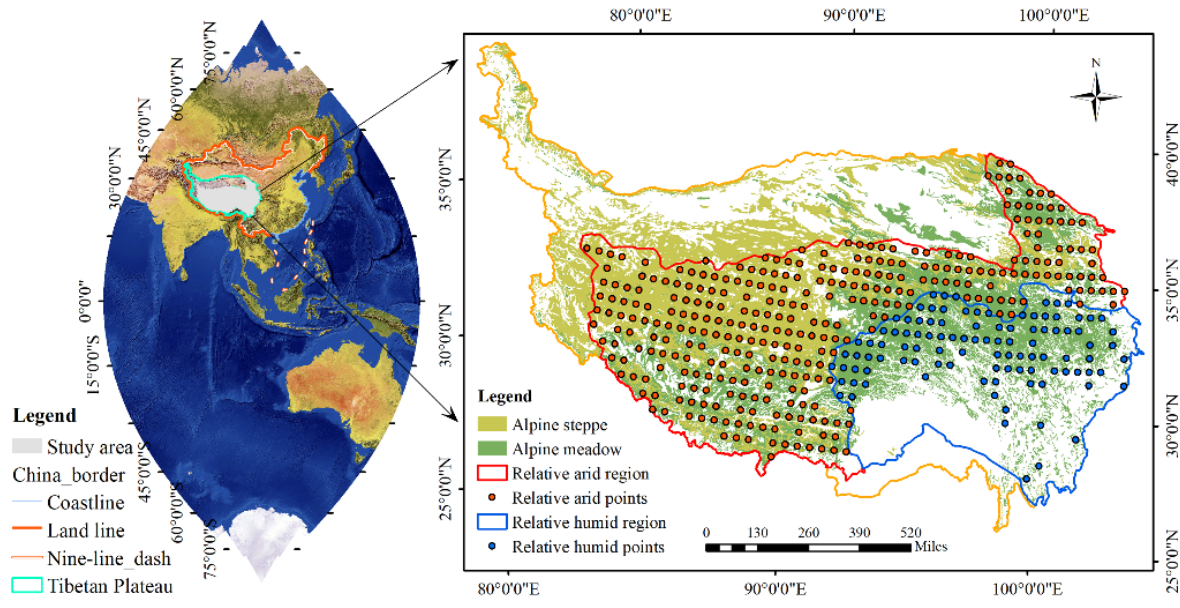
Figure 1. The climatic zones in our study.